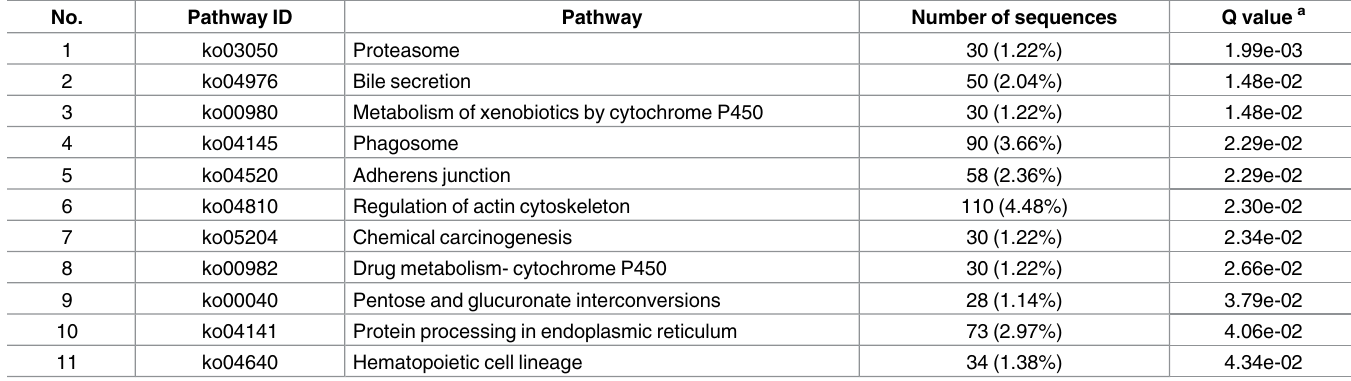
The pathway functional enrichment was analyzed using the hypergeometric test with FDR adjusted p values (cid:20) 0.01. a Significant enriched KEGG pathways were separated with a multiple correction method of Q values <